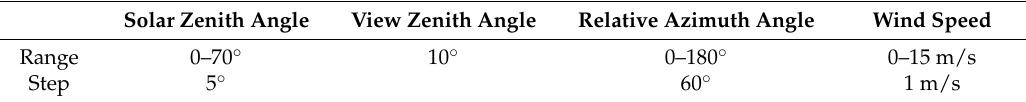
Table 7. 6S input parameters for the simulation of wind speed and solar zenith angles.